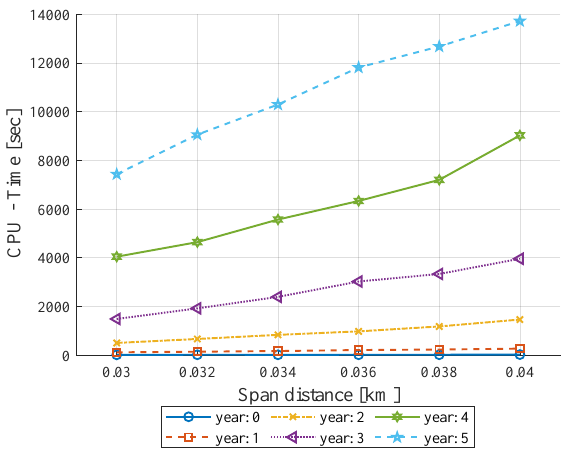
Figure 9. CPU time of modified Prim algorithm with scalability in six